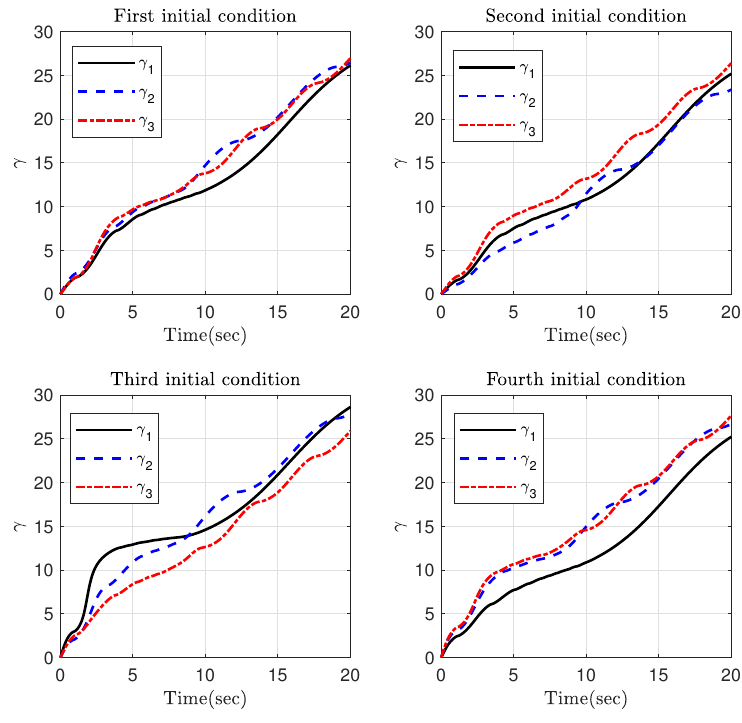
Figure 9. The parameter γ in Part 1 for different initial